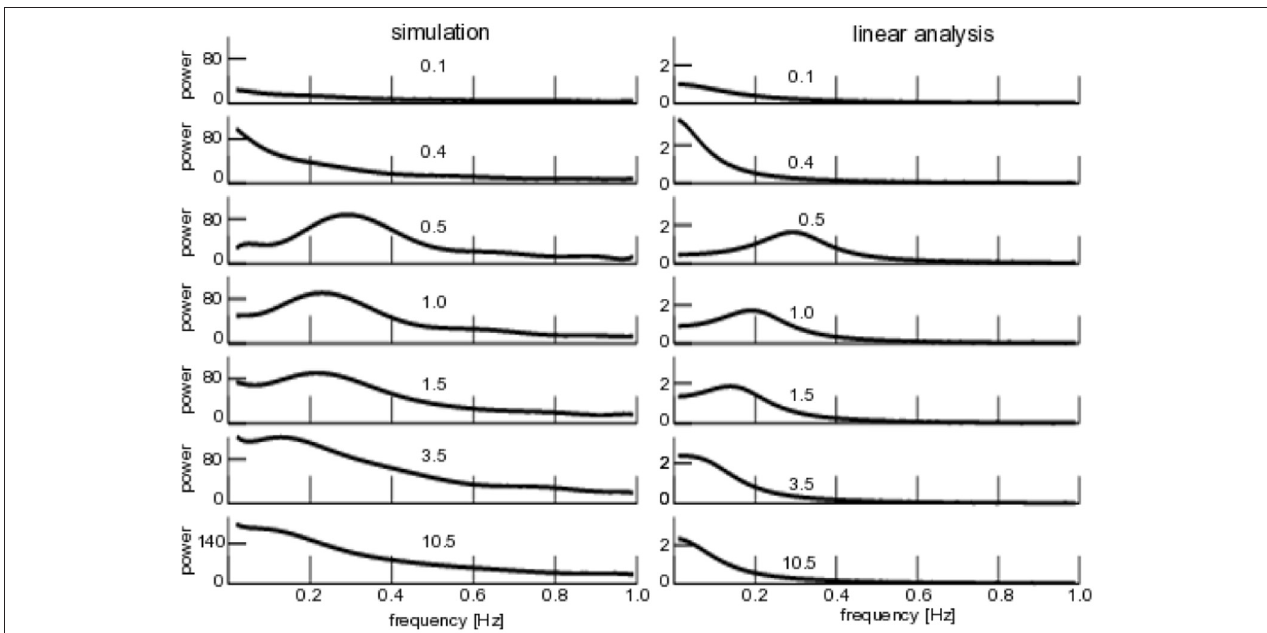
FIGURE 7 | Power spectra of ¯ V ( t ) for additive iid noise. (Left) Numerical power spectra. (Right) Analytical power spectra according to Equation (23). The numbers give the noise intensity D 1 , parameters are taken from Figure 4 .